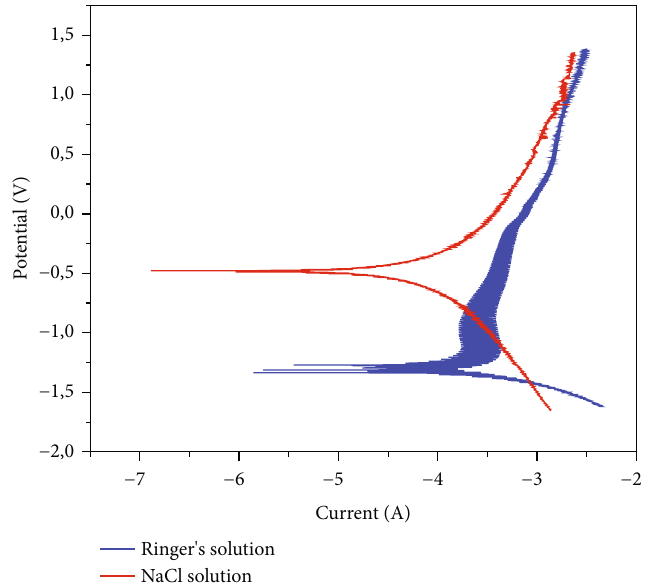
Figure 4: Tafel polarization graphs of 3D-printed samples immersed in NaCl and Ringer ’ s solutions. Table 3: Average mass loss of test specimens over time.